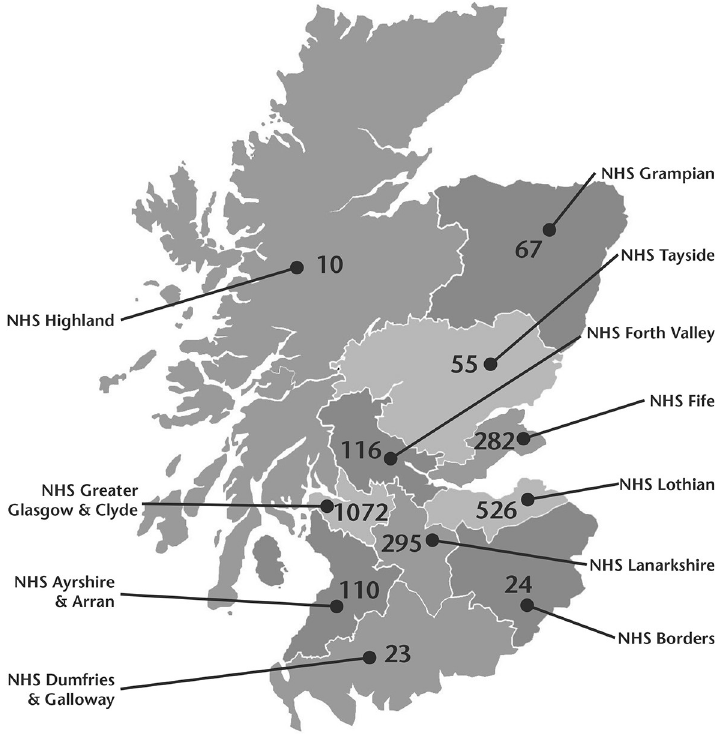
Fig 1. Map of Scotland showing population densities of the 11 mainland health